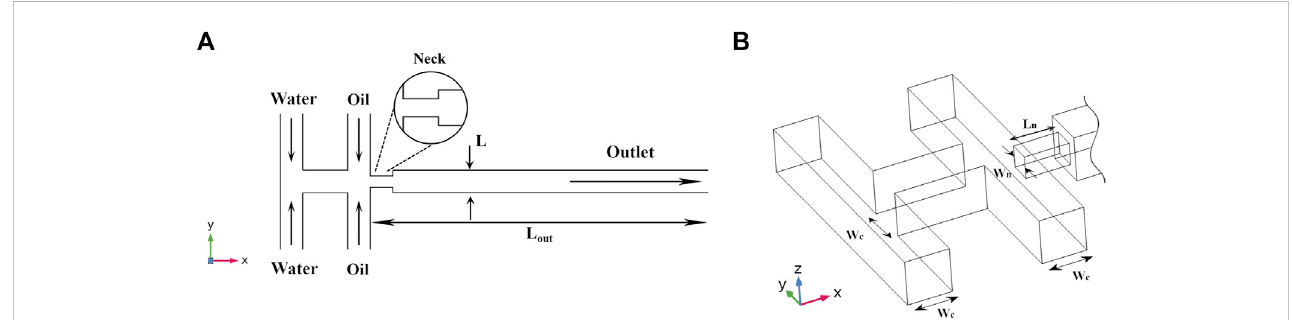
FIGURE 1 (A) Top-down view of simulation geometry, note that schematic is not to scale. Water is the dispersed phase whilst oil corresponds to the continuous phase. L out = 2 mm. L is the characteristic length, or hydraulic diameter of the channel. An enlarged top-down view of just the neck region is shown in the circle. (B) Enlarged isometric view of inlets, W c = 50 μ m, W n corresponds to the neck width which was varied between 12.5 µm and 50 µm. The neck length, L n = 50 µm. All channels were square.